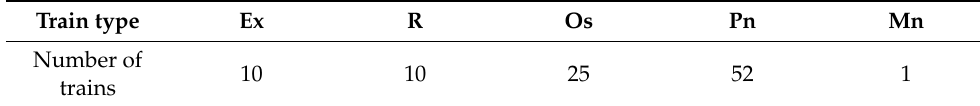
Table 1. Number and type of trains per day used in the